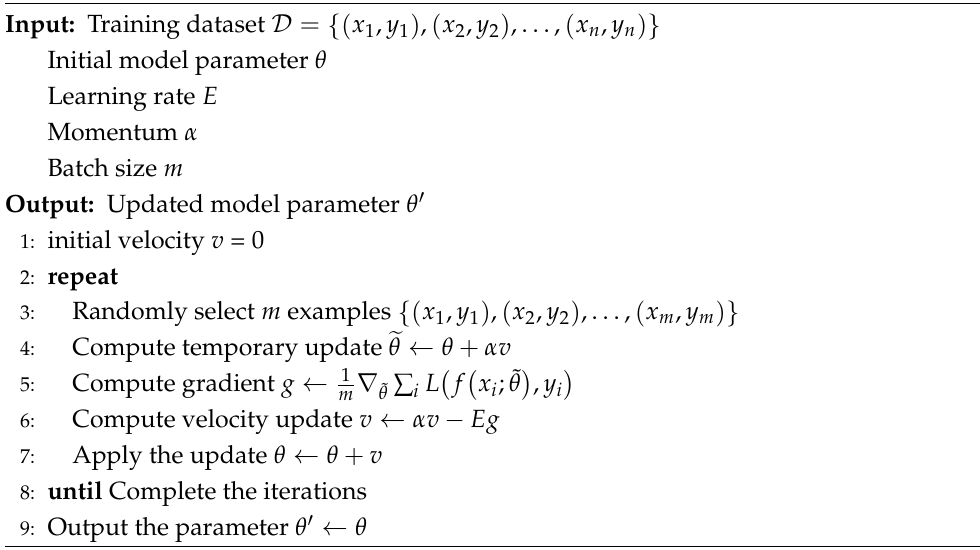
Algorithm 1 Backpropagation weight update